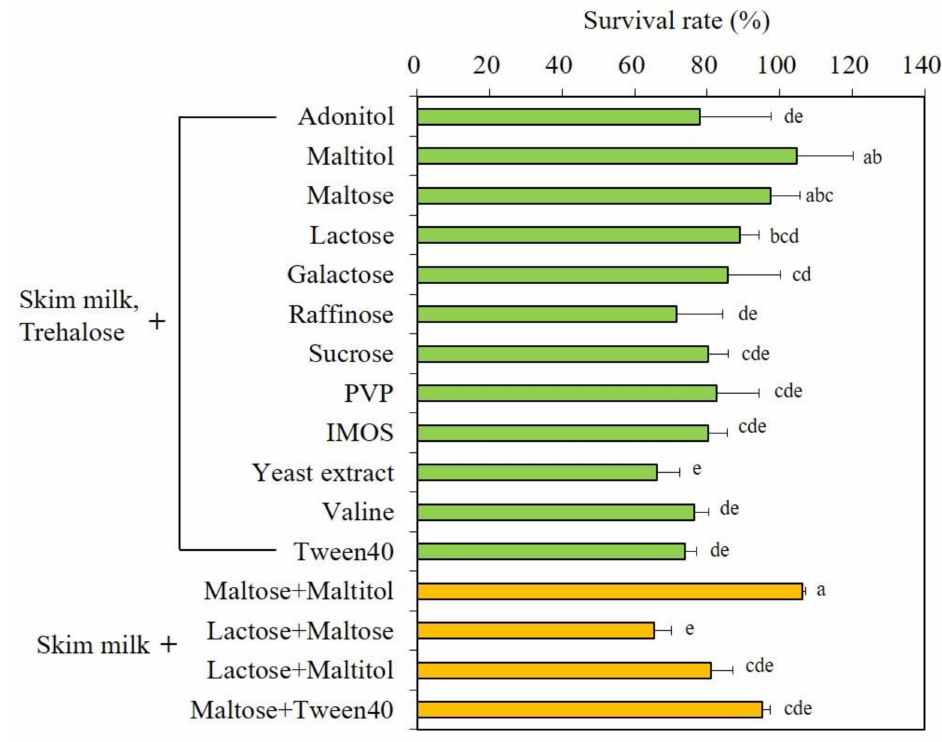
Figure 3. Triple combinatorial effects of various protectants on the survival rate of S. cerevisiae 88-4 after freeze-drying. PVP, polyvinyl pyrrolidone; IMOS, isomaltooligosaccharides. a–e Values with different letters on the bar indicate significant differences ( p <